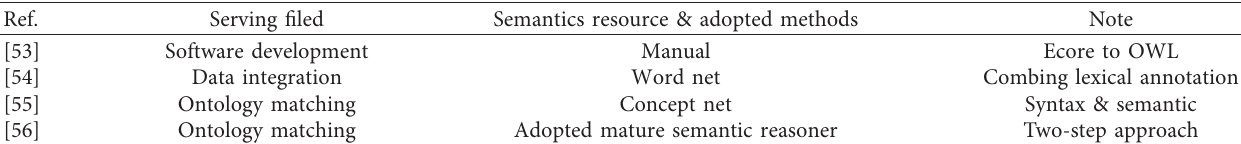
Table 14: Research works concerning